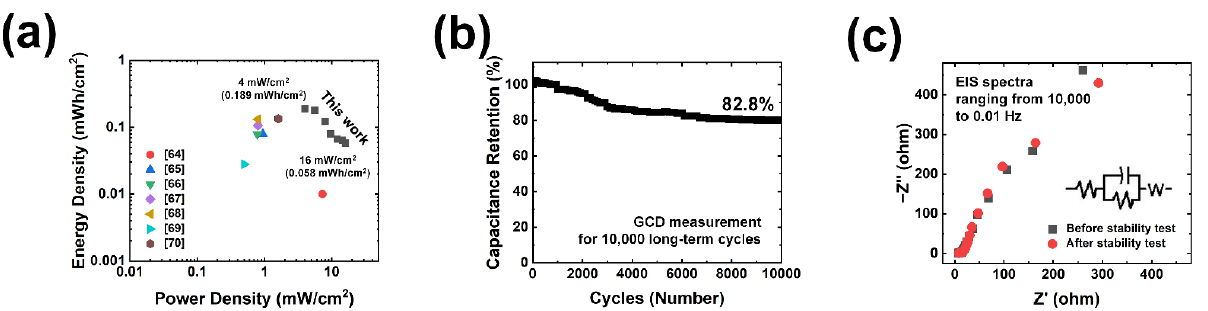
Figure 6. Electrochemical performance of assembled hybrid supercapacitor (HSC). ( a ) Ragone plots of energy and power densities of fabricated HSC device. ( b ) Long-term cyclic stability test for 10,000 GCD cycles (with high capacitance retention of 82.8%) and ( c ) EIS Nyquist plots (obtained from 10,000 to 0.01 Hz) before and after cyclic test.